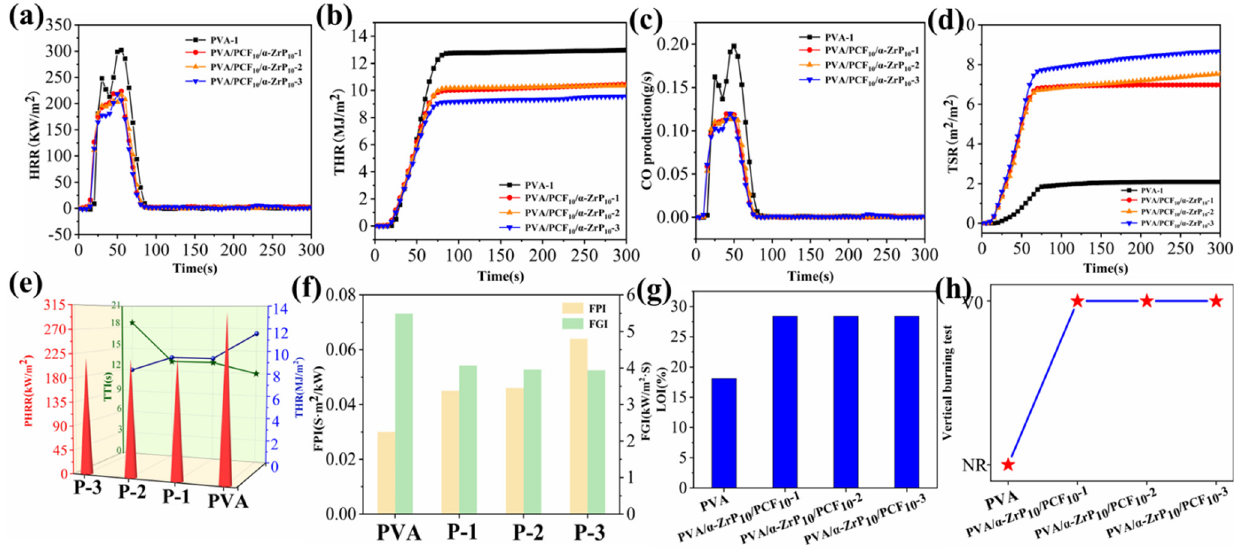
Figure 11. ( a ) HRR curves, ( b ) THR curves, ( c ) COP curves, ( d ) TSP curves, ( e ) PHRR, TTI, and THR values, ( f ) FPI and FGI values, ( g ) LOI values, and ( h ) UL-94 vertical testing of PVA and PVA/PCF 10 / α -ZrP 10 -x composite aerogels.